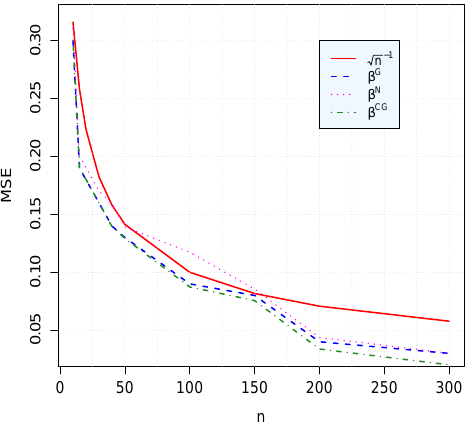
Figure 7. The MSE of ˆ β computed with Newton’s, gradient and conjugate gradient